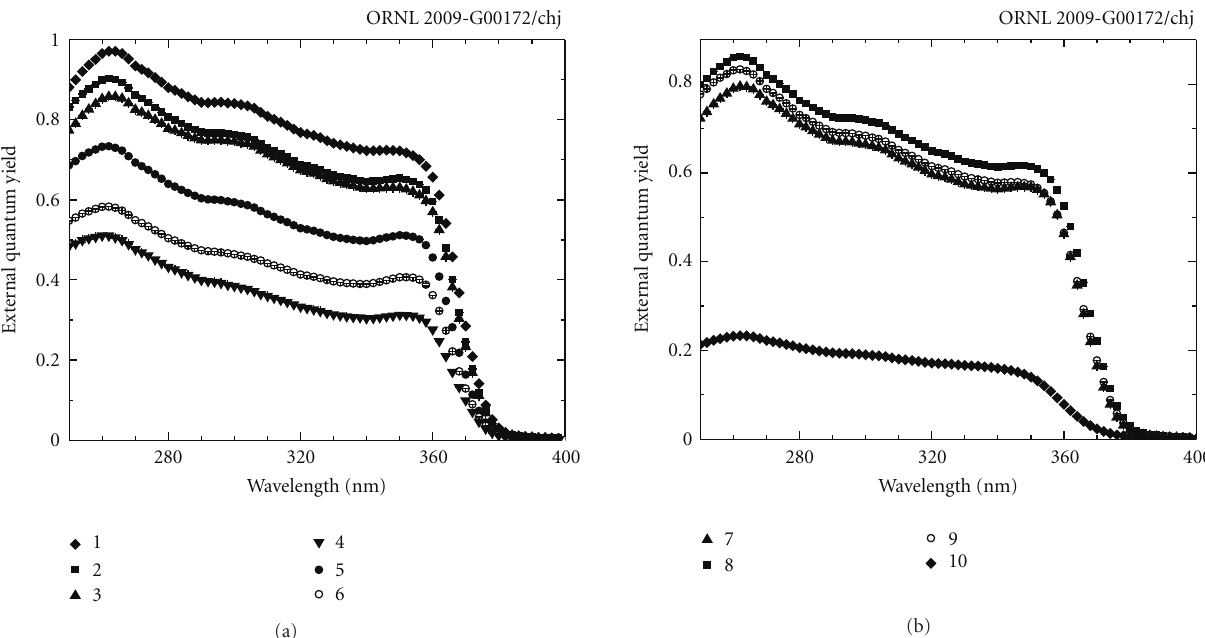
Figure 11: Spectral photocurrent quantum yield of the various single-crystal ZnO semiconducting photoanodes for (a) the thermochemically doped (1)–(6) samples and (b) the samples (7)–(9) doped in the melt during growth. The quantum yield correlates well with carrier concentration (see Table 1), where lower carrier concentrations result in a larger quantum yield.